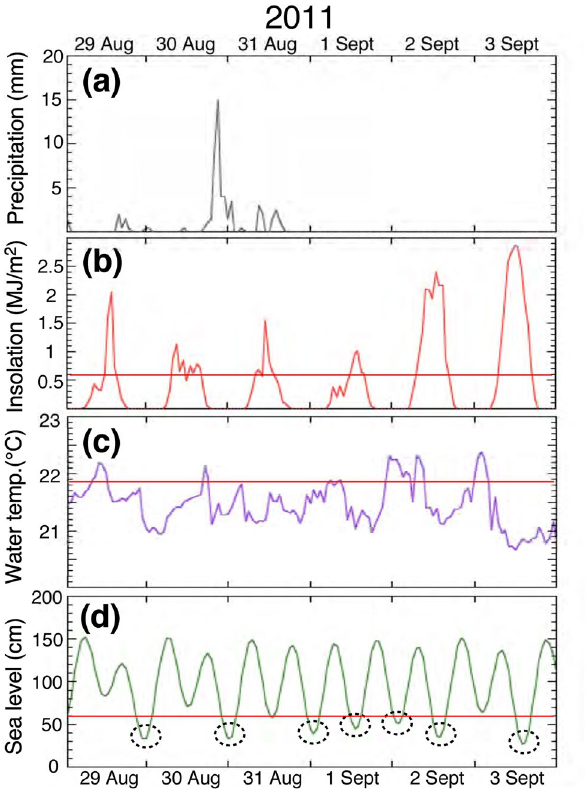
Figure 5. Environmental data from August 29th to September 3rd, 2011 in the studied region. ( a ) A record of hourly precipitation in Miyako Bay, located 40 km north of the sampling site. ( b ) A record of hourly insolation in Morioka city, 75 km northwest of the sampling site. A red line shows an arbitrary threshold value (0.6 MJ/ m 2 ). ( c ) A record of hourly surface seawater temperature in Hirota Bay, 45 km southwest of the sampling site. The data from an open database provided by a local government (https:// www. suigi. pref. iwate. jp/ teichi). A red line shows a threshold value that is the temperature one sigma higher than the average. ( d ) A record of hourly sea level change calculated by astronomical data in Kamaishi Bay, 9 km south of the sampling site. The all data from the nearest observation point to the sampling site, which are provided from the Japan